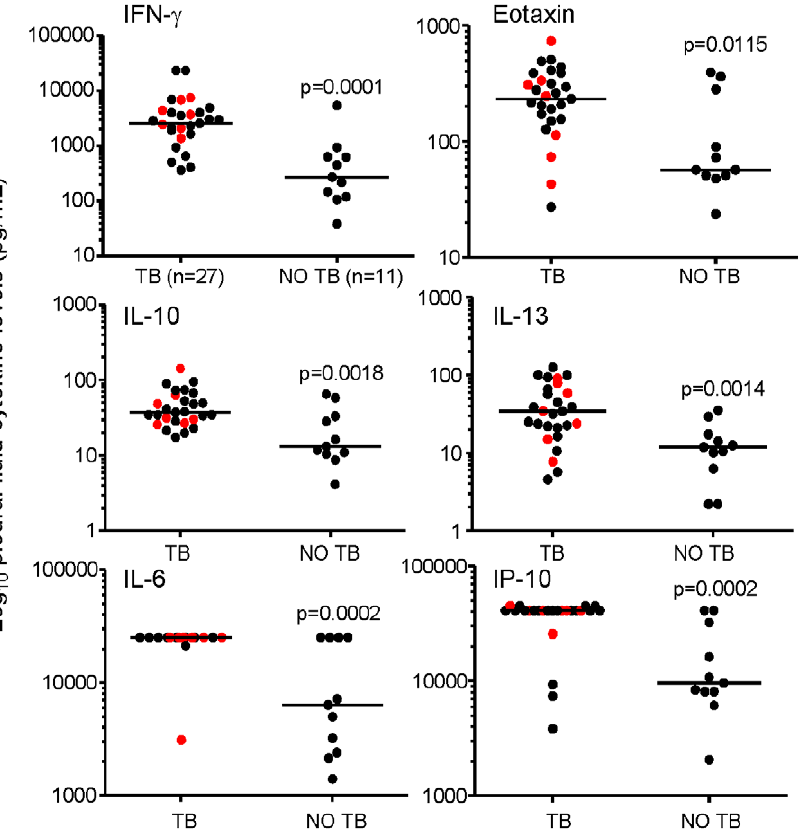
Figure 3. Multiplex cytokine analysis of ex vivo pleural fluid samples. Pleural fluid from subjects with TB (n=27) and subjects without TB (n=11) was assessed for 27 different cytokines using a Bioplex multi-cytokine analyser. Results are shown for IFN- c , Eotaxin, IL-10, IL-13, IL6 and IP-10 levels in unstimulated fluid. Statistical analysis was performed using logistic regression analysis with Stata 3 software and multiple comparisons corrected for using Bonferonni’s correction. Significance was set at p , 0.05 and are indicated. Red dots indicate HIV-positive